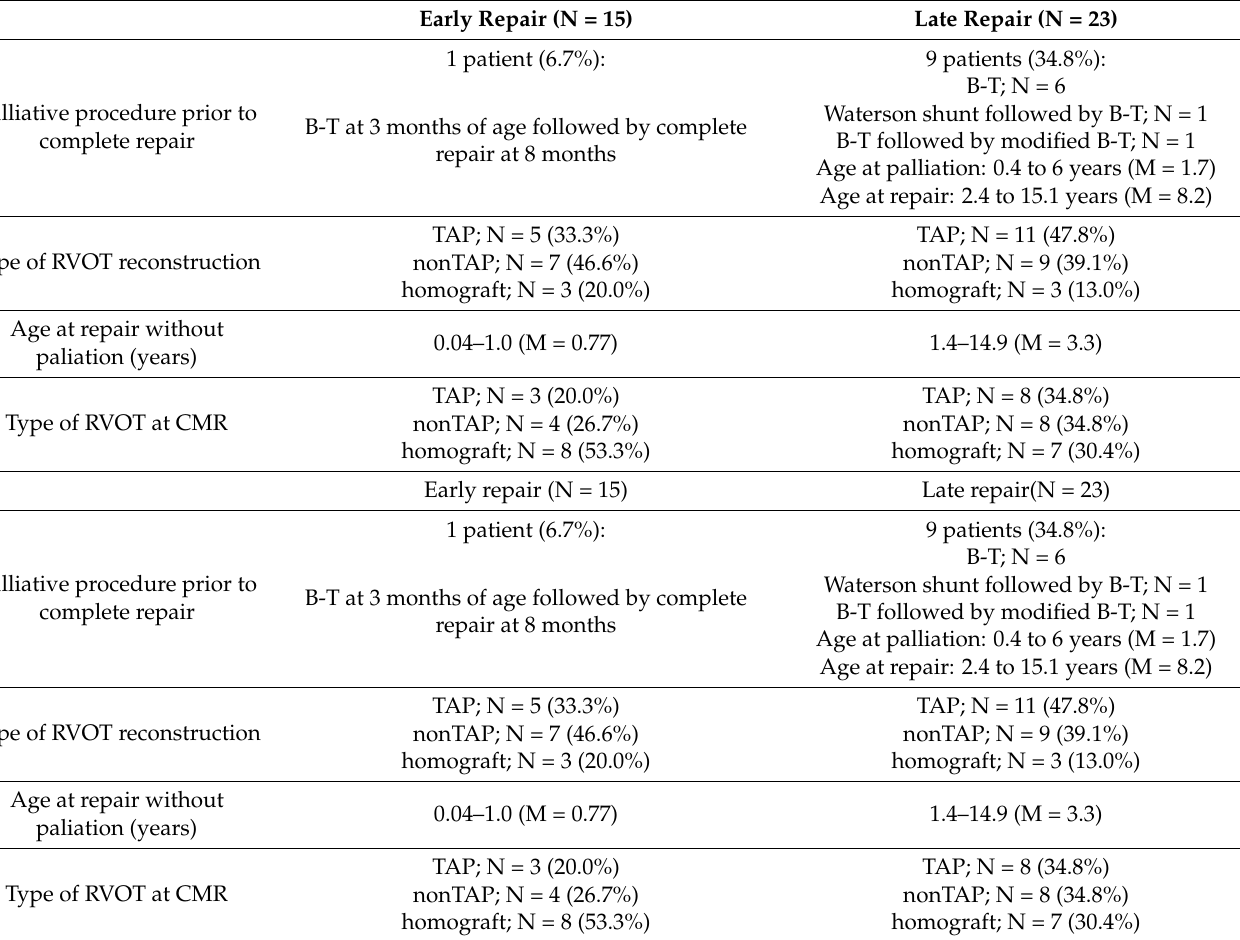
Table 1. Clinical data regarding patients after early and late repair; B-T—Blalock-Taussig shunt; CMR—cardiac magnetic resonance, M—median; RVOT—right ventricular outflow tract; TAP—transannular patch; and nonTAP—nontransannular RVOT